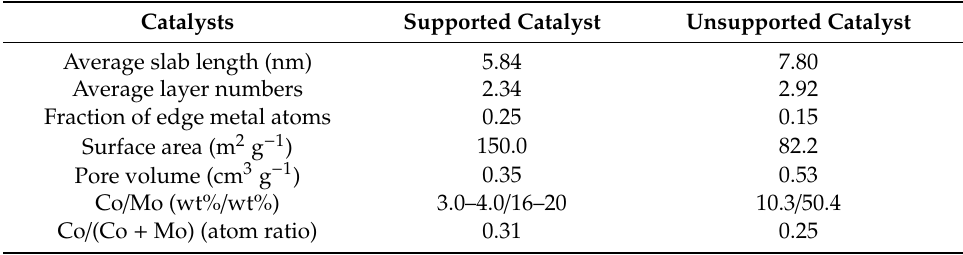
Table 1. Basic properties of unsupported and supported CoMoS catalysts.